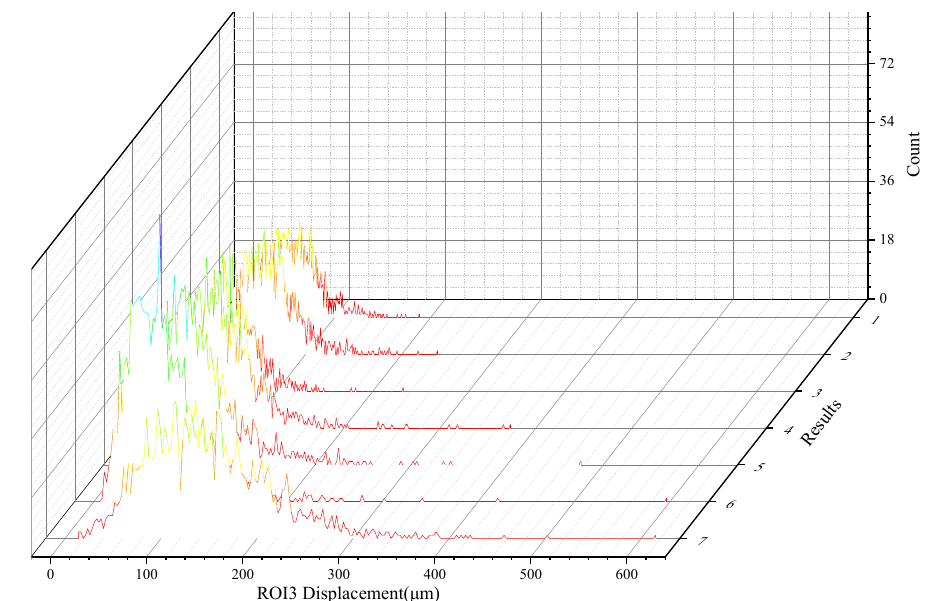
Figure 11. Statistical results for the ROI3 displacement field at different stages (stage 2 to 8).